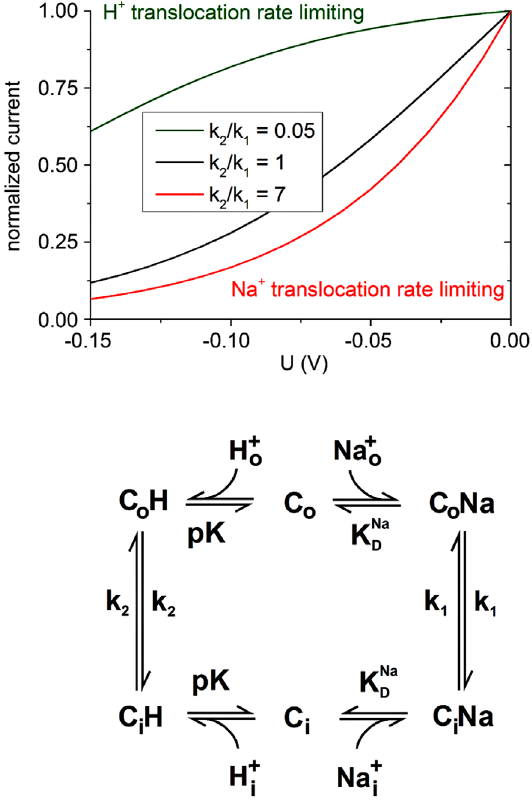
Figure 6. Current voltage relationship and kinetic model. Using the kinetic model given in the lower panel and the parameters for substrate binding of wild type NhaA (pK=8.8, K D for Na=3 mM [15]) the current voltage relationship of the Na + /H + exchanger was calculated. For comparison three different values of the k 2 /k 1 ratio, the ratio of the rate constants of the Na + and the H + translocation reaction, were used in the calculation: k 2 /k 1 =7 corresponds to WT NhaA where Na + transport is rate limiting. k 2 /k 1 =0.05 corresponds to F267C NhaA where H + transport is rate limiting. k 2 /k 1 =1 is an intermediate case. For comparison, currents are normalized to their respective values at voltage U=0V.